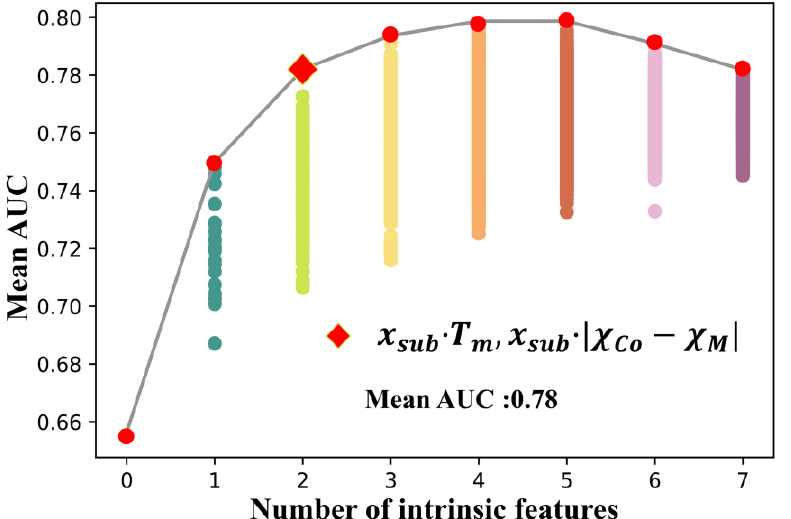
Figure 3. The mean AUC values of all feature subsets . The dots of different colors indicate the mean AUC corresponding to the subset with various numbers of features. The scattered points overlap with each other due to the large number of subsets with high numbers of features. The red points indicate the mean AUC of optimal feature subsets for different numbers, and the diamond represents the intrinsic features that we finally chose for machine learning.